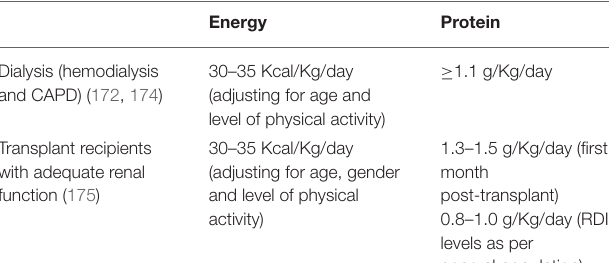
TABLE 3 | Energy and protein intake recommendations for patients on dialysis and transplant recipients.